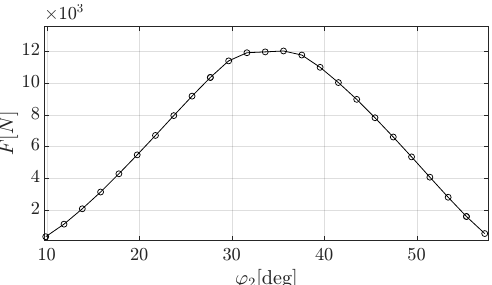
Figure 2. Load shared by the contacting teeth over a mesh